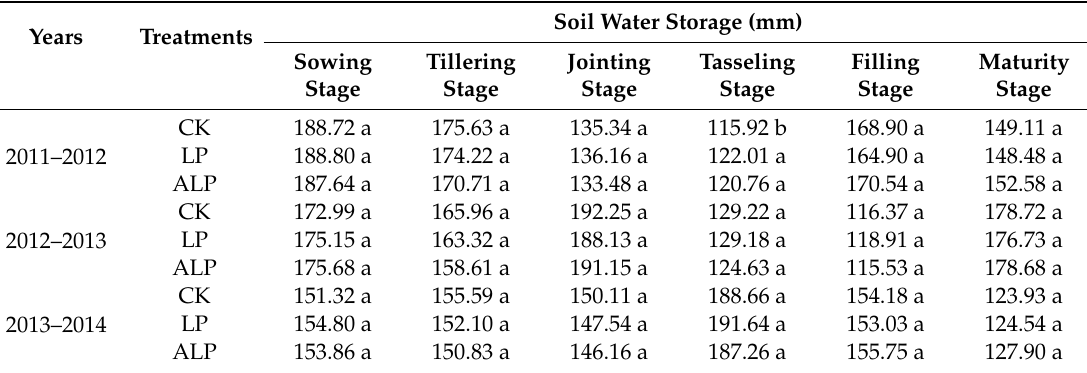
Table 2. Soil water storage in the 0 − 60 cm soil layer at various growth stages of winter wheat as influenced by di ff erent straw incorporation